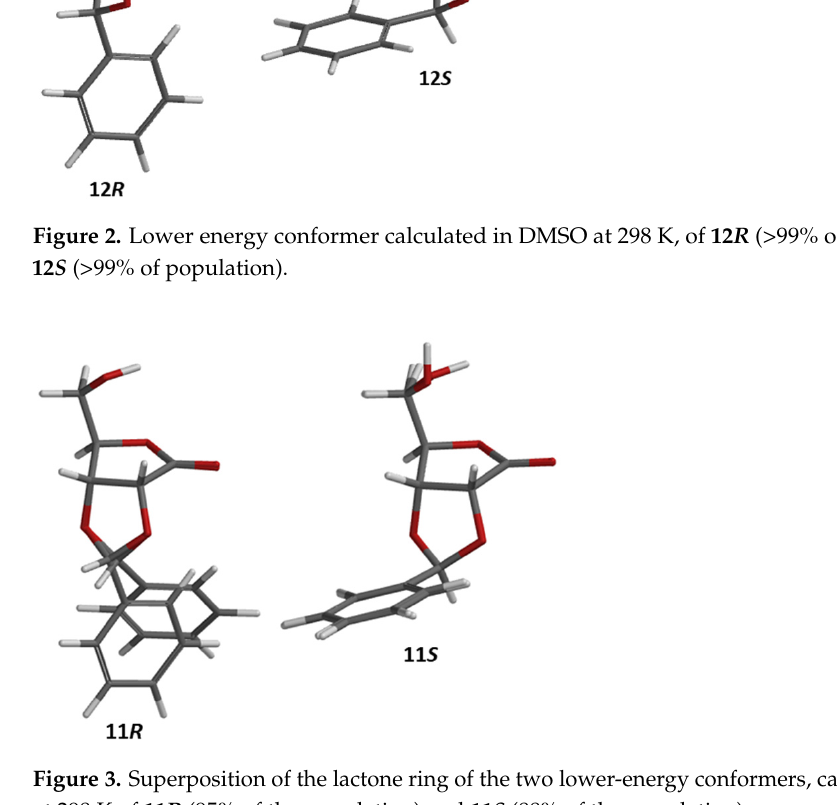
Figure 3. Superposition of the lactone ring of the two lower-energy conformers, calculated in CHCl 3 at 298 K of 11 R (95% of the population) and 11 S (88% of the at 298 K of 11 R (95% of the population) and 11 S (88% of the population). The puckering parameters of the furanosidic lactone rings, identical for these two main conformers (puckering amplitude q 2 = 0.20 Å and pseudorotation phase angle ϕ 2 = 122°), indicate a conformation of the ring intermediate between twist and envelope ( 4 T 3 /E 3 ).